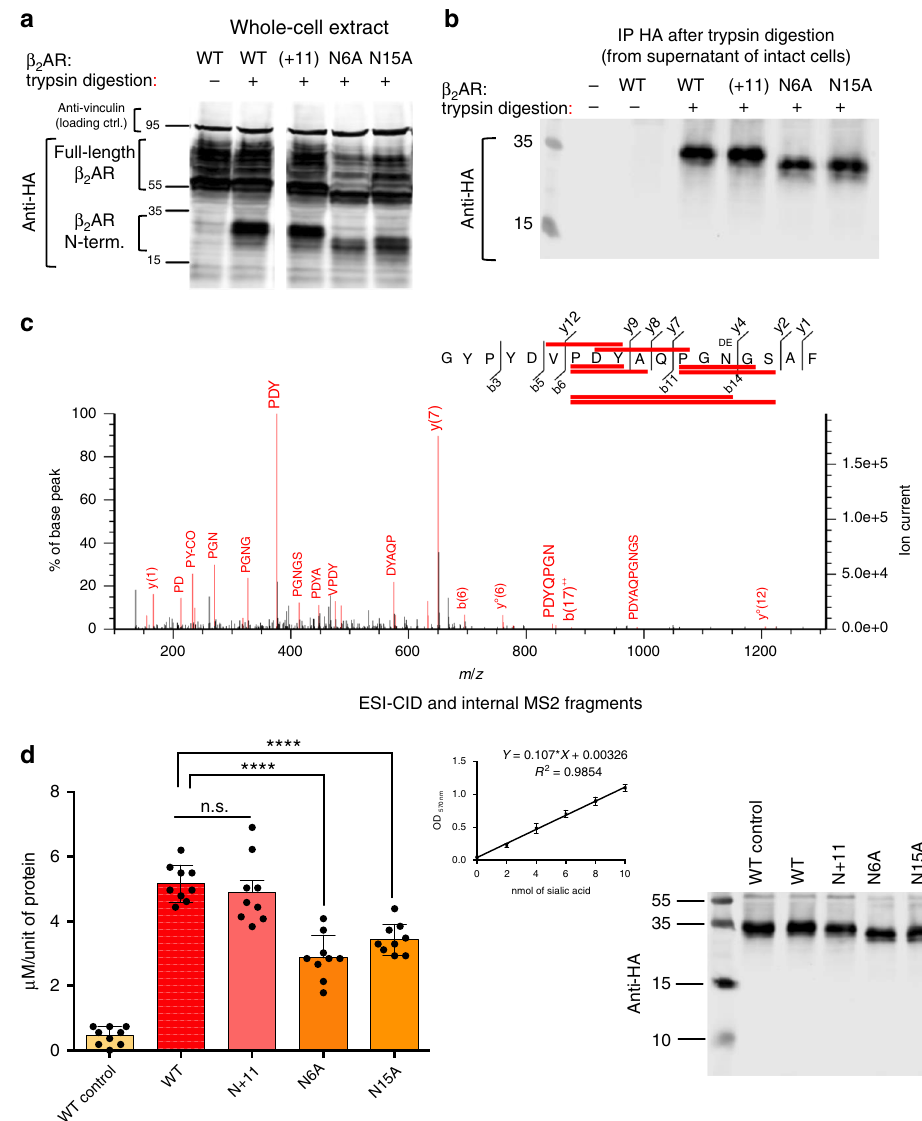
Fig. 4 Sialylation of N-glycan chains at positions 6 and 15 of the β 2 AR N-terminus. a Western blot analysis of whole-cell lysates from HEK-293 cells expressing wt or mutant HA-tagged β 2 AR (description in Supplementary Fig. 7a). Intact cells were submitted to trypsin digestion (see Methods) to cleave the N-terminus of surface receptors. After the addition of Laemmli buffer directly to the mixture and PAGE separation, WB membranes were probed with the indicated antibodies. The 36-residue glycosylated N-termini produced by the tryptic digestion migrate faster than the corresponding un-cleaved receptors. The N-termini from N6A and N15A β 2 AR, which contain only one Asn-branched glycan chain display a lower apparent MW than wt or ( + 11) β 2 AR. b Supernatants of the same cells submitted to trypsin digestion were incubated with anti-HA-tag-coated beads to immunoprecipitate the released N-termini. c Immunoprecipitated N-termini were additionally digested with PNGase and chymotrypsin to generate glycan-free peptides for MS analysis. The shown chromatogram corresponds to the analysis of the wt β 2 AR N-terminus. Spectrum annotation (b- and y-ion series) was done according to nomenclature of peptide fragmentation 61 . Indicated matched internal fragments (red bars) correspond to higher intensity peaks, mostly proline-starting fragments 62 produced by higher energy collisional dissociation (HCD)-type high-resolution mass spectrometer. Indeed, the presence of proline residues causes increased peptide fragility at their N-terminal side during collisionnal-induced decay (CID) 63 . The DE N residue corresponds to the change of an asparagine residue into an aspartic acid due to the enzymatic (PNGase) removal of N-linked glycans. d Receptor N-termini bound to HA-coated beads were heated in acidic conditions to release Neu5Ac from the glycan chains; liberated sialic acid was quanti fi ed by a colorimetric assay (see Methods). Left panel: amount of sialic acid released from the indicated N-termini. “ WT control ” corresponds to a sample of wt β 2 AR bound to HA breads maintained in PBS buffer without acidic treatment. Values of Neu5Ac obtained with the assay were calibrated with the actual protein concentration of the N-terminal fragments determined by quantifying WB images (LI-COR software) (ANOVA: **** p < 0.0001, 9 samples for each condition, prepared from 3 independent batches of transfected cells). Middle panel: standard curve. Right panel: representative WB used to quantify the indicated N-terminal fragments. n.s., not signi fi to induce signaling in hCMEC/D3 cells. Supporting the con- their activation. To address this hypothesis, in a dedicated tribution of pilus retraction in receptor activation, ezrin recruit- experimental protocol designed to minimize the exogenous forces ment was signi fi cantly impaired under Δ T meningococci applied on bacteria (see Methods), wt and mutant meningococci compared to wt under basal, static conditions (Fig. 6a, b). In de fi cient in PilT activity ( Δ T 30 ) were compared for their capacity